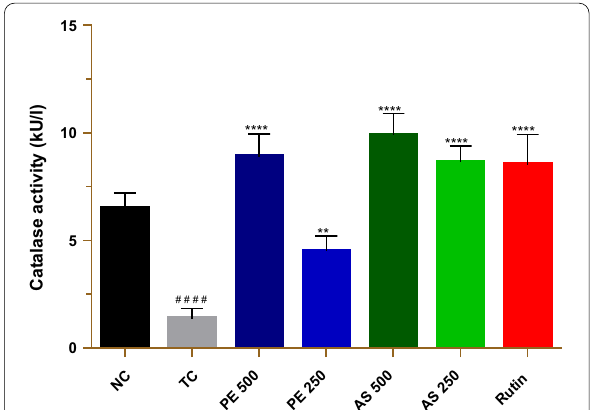
Fig. 3 Effect of P. erinaceus and A. spinosus in GSH levels in lenses. Fig. 4 Effect of P. erinaceus and A. spinosus in catalase activity in NC normal control under 5.5 mM glucose; TC toxic control under = = lenses. NC normal control under 5.5 mM glucose; TC toxic 55 mM glucose; PE and AS 500; 250 P. erinaceus and A. spinosus = = = control under 55 mM glucose; PE and AS 500; 250 P. erinaceus and at doses of 500 and 250 mg/kg bw 55 mM glucose; Rutin rutin = + = A. spinosus at doses of 500 and 250 mg/kg bw 55 mM glucose; at a dose of 500 µg/kg bw 55 mM glucose. The values were + + Rutin rutin at a dose of 500 µg/kg bw 55 mM glucose. The analyzed with a one‑way ANOVA and then expressed as mean SEM. = + ± values were analyzed with a one‑way ANOVA and then expressed as ### p < 0.001 compared to NC; ** p < 0.01; *** p < 0.001, compared to TC. mean SEM. #### p < 0.0001 compared to NC; ** p < 0.01; **** p < 0.0001; ± compared to TC. n =